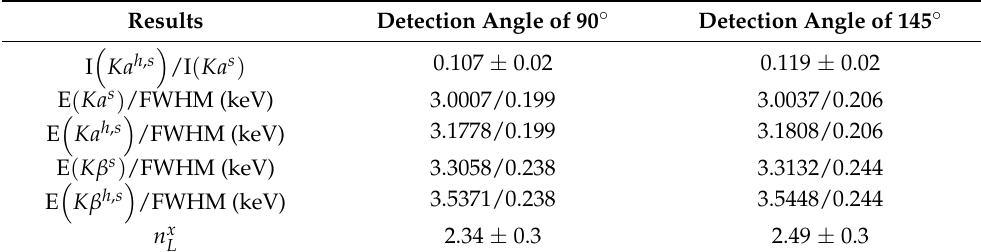
of argon in collision L